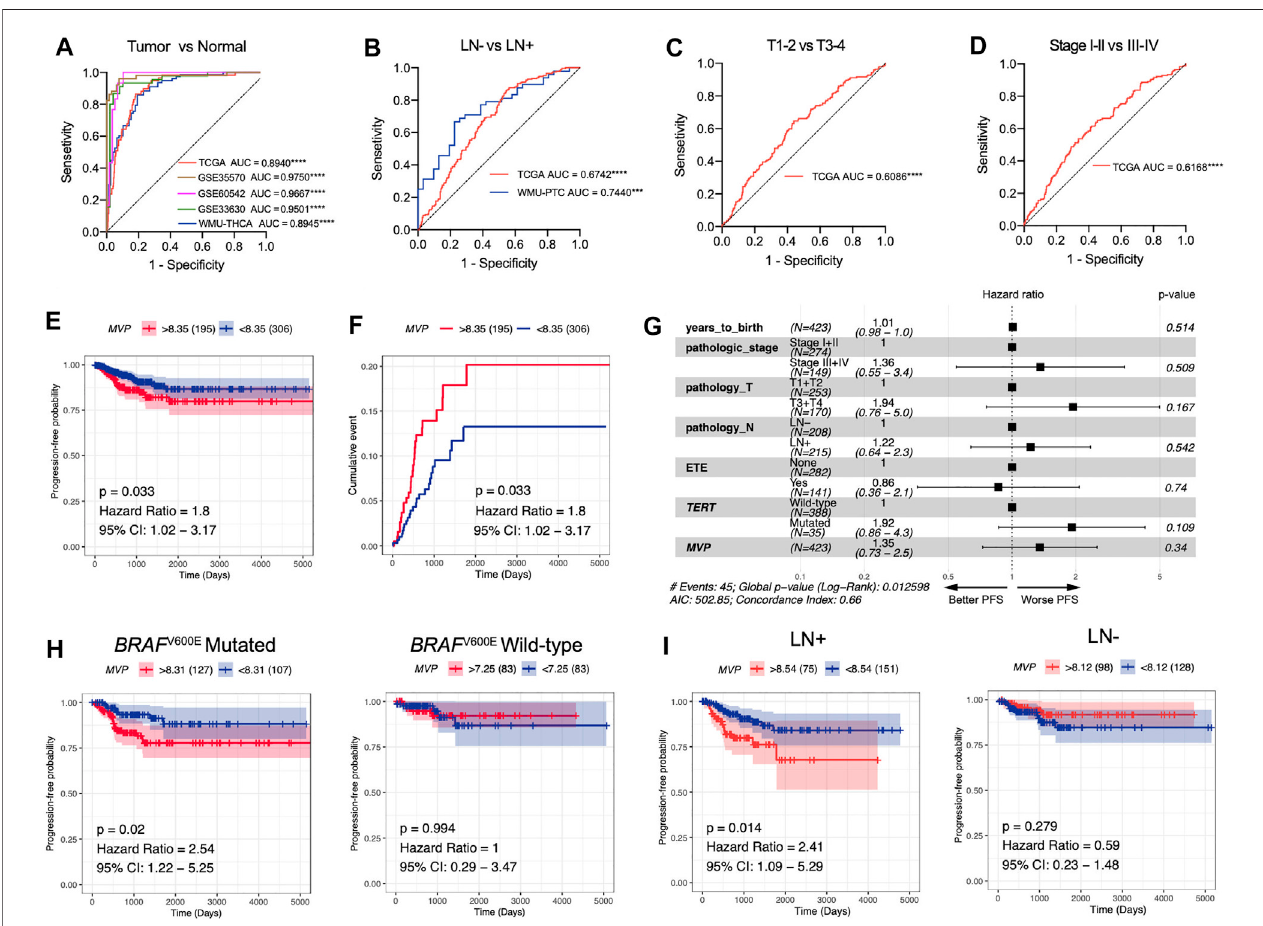
FIGURE 4 | MVP is a promising diagnostic and prognostic factor in PTC. (A) ROC curve analysis revealed the diagnostic potential of MVP in PTC patients derived from public datasets and local WMU-PTC cohort. (B-D) ROC curve analysis exhibited the prediction capabilities of MVP in (B) LNM status, (C) tumor size, and (D) disease stage. (E, F) Survival curves contrast MVP high and MVP low patients together with the log-rank test. The p-value and hazard ratios (HR) with 95% con fi dence interval(CI)arecalculated. (G) MultivariableCoxregressionanalyses ofPFSinPTC patients. (H,I) Kaplan – Meiercurves contrast MVP high and MVP low patients with different (H) BRAF V600E phenotype and (I) lymph node status. * p < 0.05, ** p < 0.01, *** p < 0.001, **** p < 0.0001.